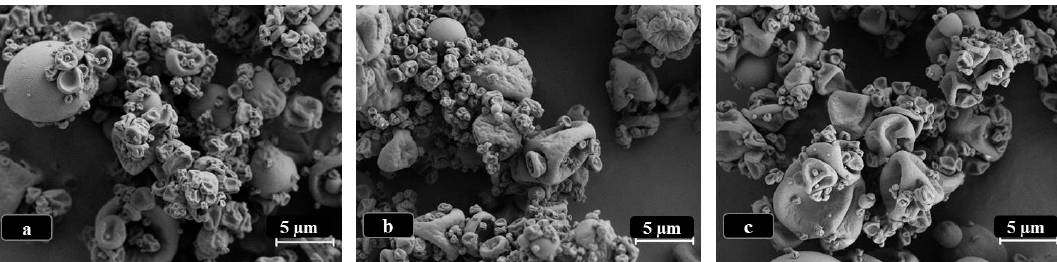
Figure 2. Microphotographs of LBG-based microparticles viewed by scanning electron microscopy. ( a ) Unloaded LBG microparticles; ( b ) LBG:INH = 10:1 ( w / w ) microparticles; ( c ) LBG:RFB = 10:0.5 ( w / w ) microparticles, the latter representative of formulations containing different amounts of RFB; INH: isoniazid, LBG: locust bean gum, RFB: rifabutin.